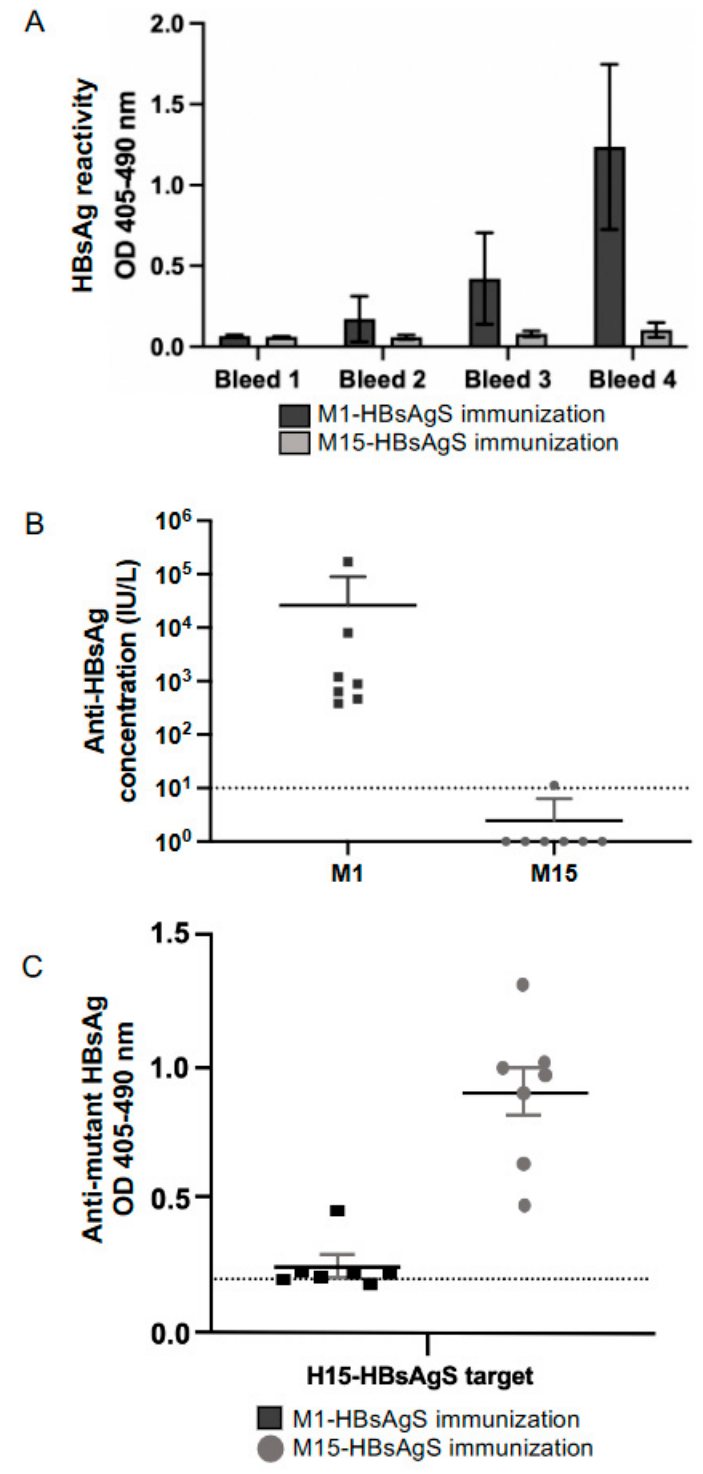
Figure 2. Immunoreactivity of M1- and M15-HBsAgS VLPs. For the generation of antisera, groups of seven BALB/c mice were immunized four times at two-week intervals with 2 µ g of M1- and M15-HBsAgS VLPs. The generated antibody responses were assessed using ( A ) an in-house ELISA with yeast-derived wt HBsAgS VLPs as targets, at a 1:250 serum dilution, in duplicate, graphed mean ± standard deviation (SD), ( B ) the anti-HBsAg diagnostic assay Elecsys anti-HBs II (detection threshold <10 IU/L), and ( C ) a mutant HBsAgS-specific ELISA with coated HA-tagged mutant H15-HBsAgS. The cut-off value at 0.2 OD is shown by a dashed line.